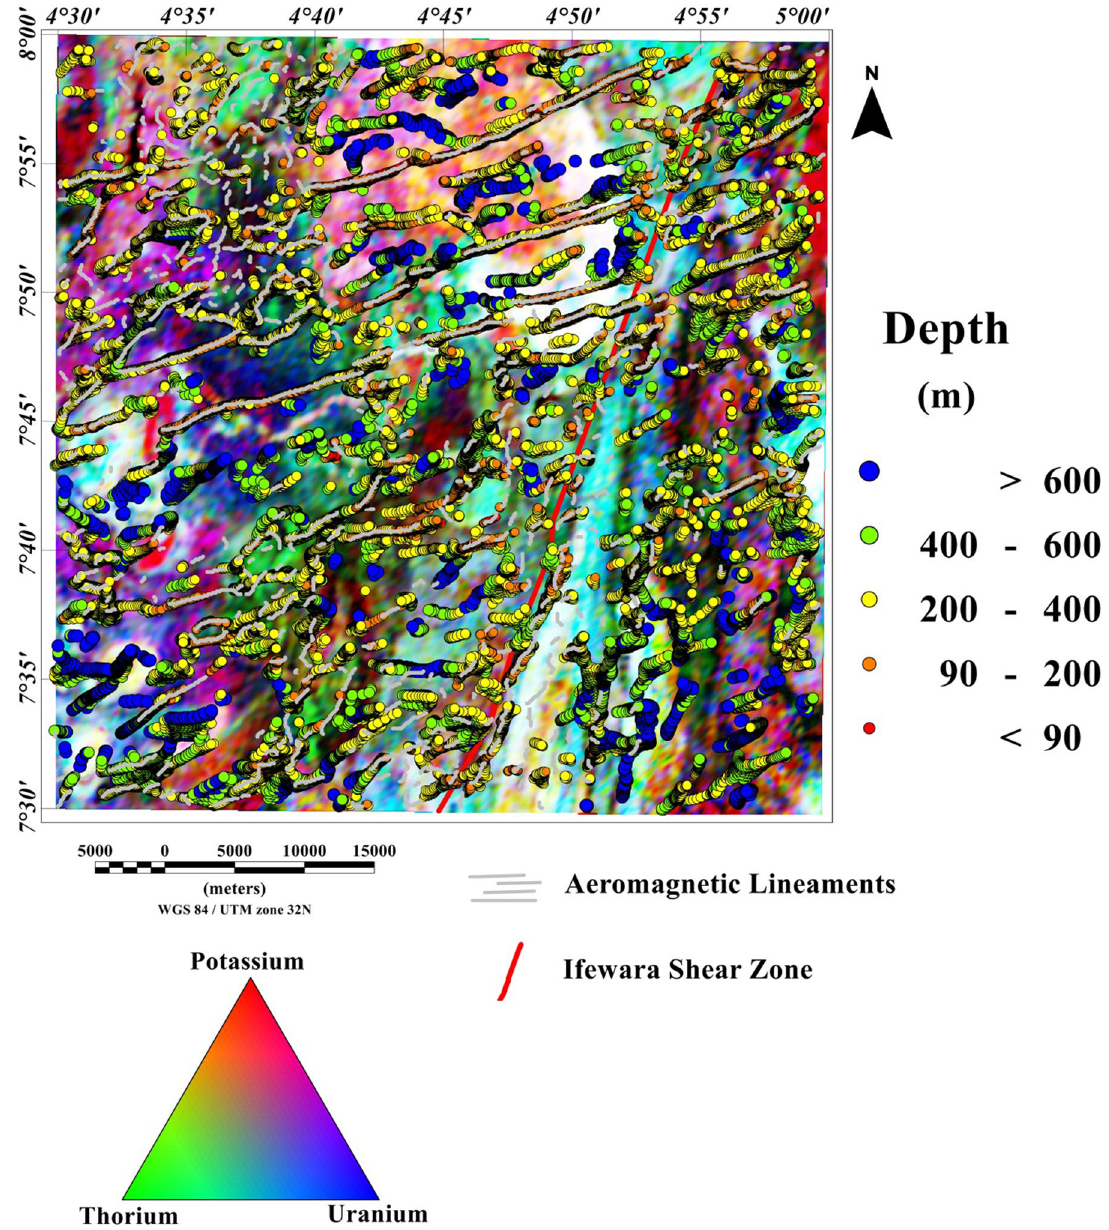
Figure 19. Ternary map of the Ife-Ilesha schist belt with superimposed 3-D Euler depth solutions and aeromagnetic